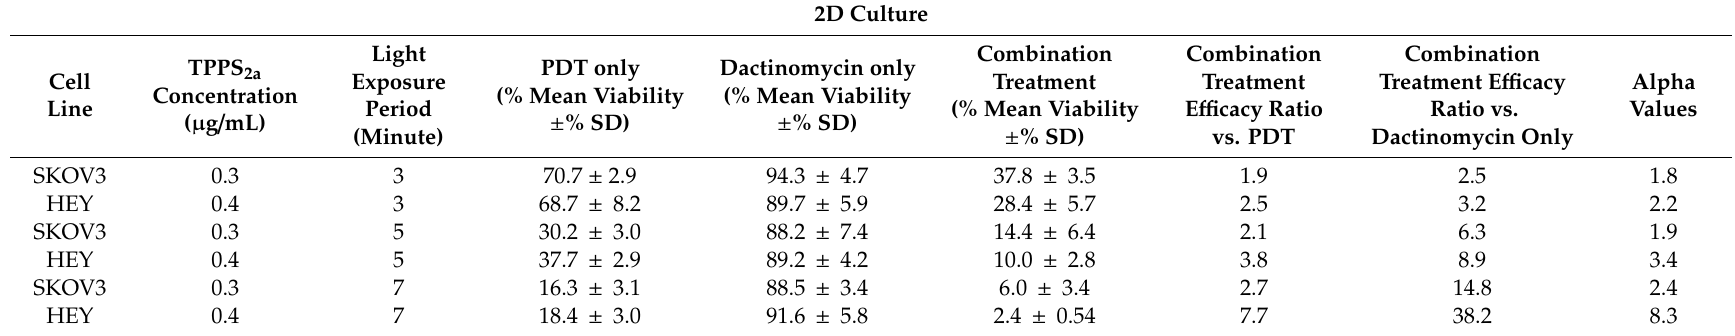
Table 1. Summary of percentage viabilities ± % SD, combination treatment e ffi cacies and alpha values in 2D monolayer cultures of SKOV3 and HEY cells. The concentration of Dactinomycin used was 1 nM. The cells were incubated for 48 h post light exposure before terminating the experiment. The measurements were obtained with Alamar Blue assay.